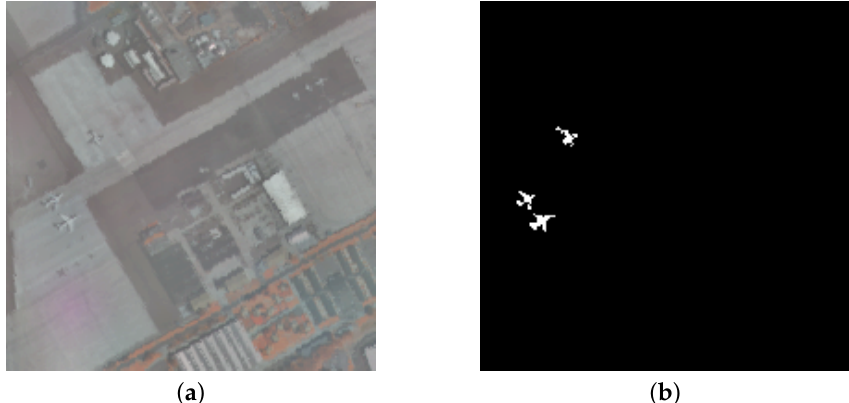
Figure 7. Illustration of the San Diego dataset: ( a ) false color (RGB: 60, 30, 20); ( b ) the ground-truth